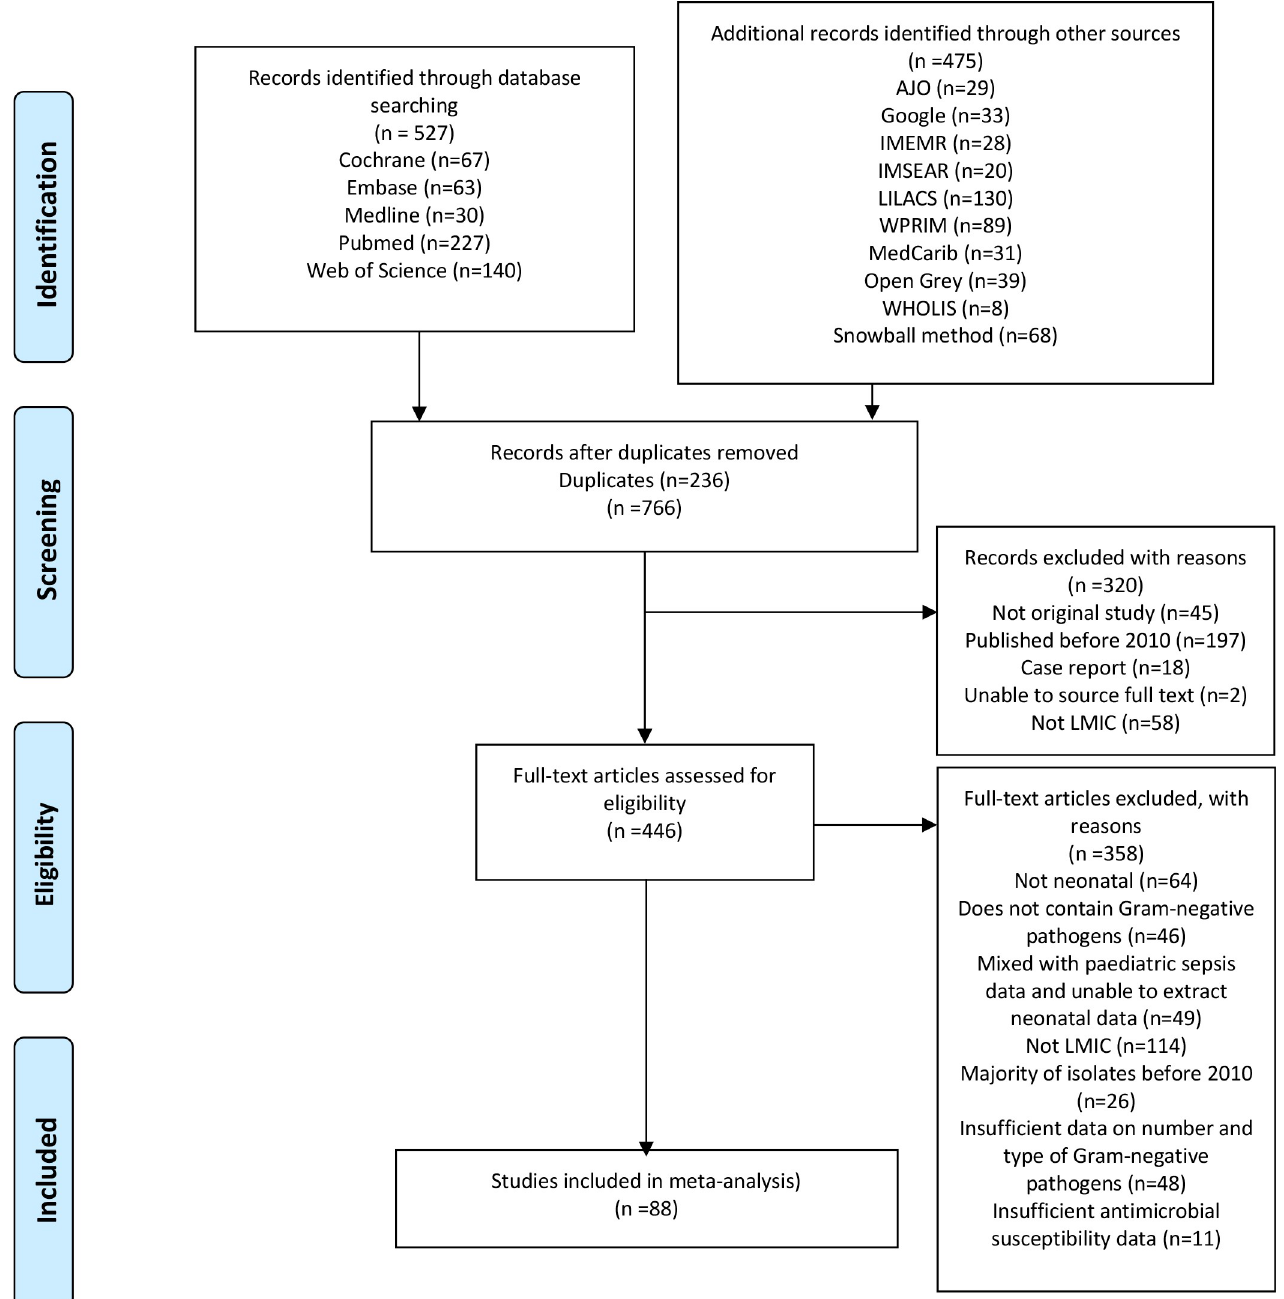
Fig 1. Study selection. AJO, African Journals Online; IMEMR, Index Medicus for the Eastern Mediterranean Region; IMSEAR, Index Medicus for South-East Asia Region; LILACS, Latin American and Caribbean Health Sciences Literature; LMIC, low- or middle-income country; WPRIM, Western Pacific Region Index